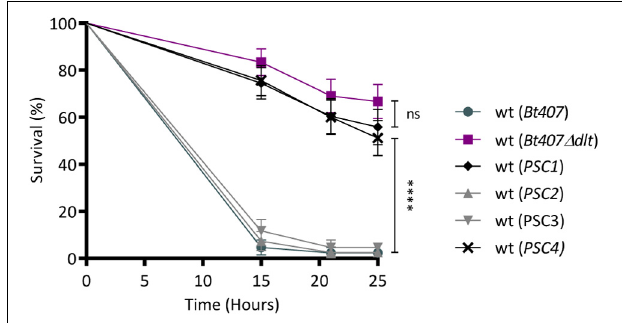
FIGURE 1 | Identification of novel genes involved in Bt407 virulence in Drosophila . Survival of wild-type flies (wt) to an infection with Bt407 , Bt407 (cid:49) dlt or the four Bt mutants preselected as Polymyxin B Sensitive Clones ( PSC ). Data are representative of three independent experiments (mean ± SD). Statistical tests were performed using Log Rank test (ns: p > 0.05, ∗∗∗∗ p <